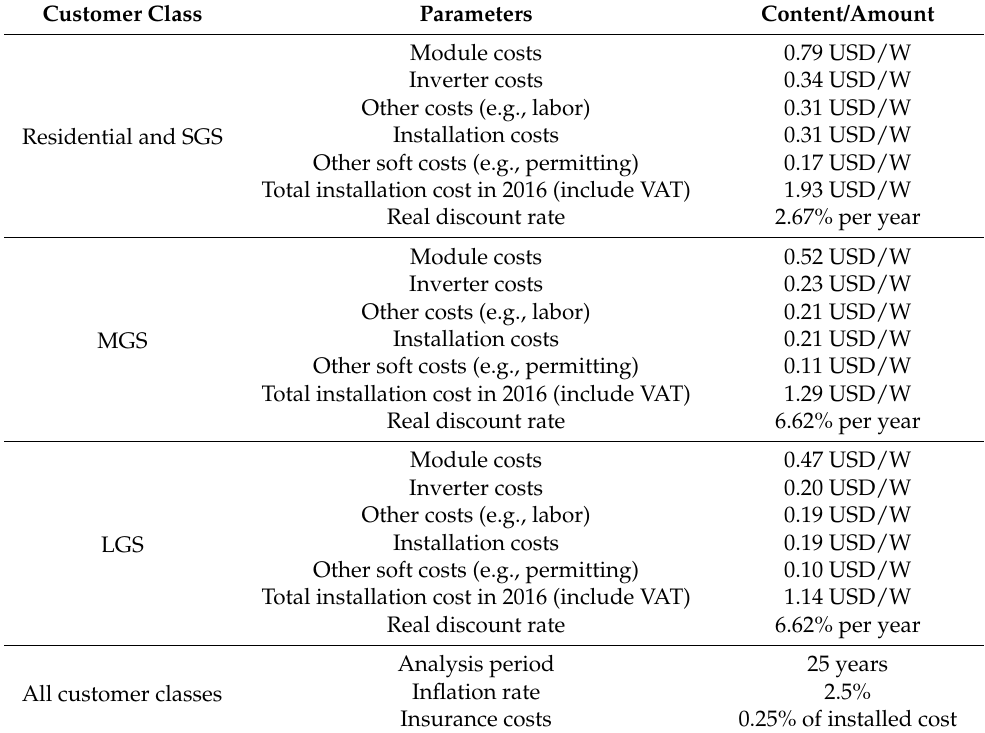
Table A4. Economic and financial assumptions.